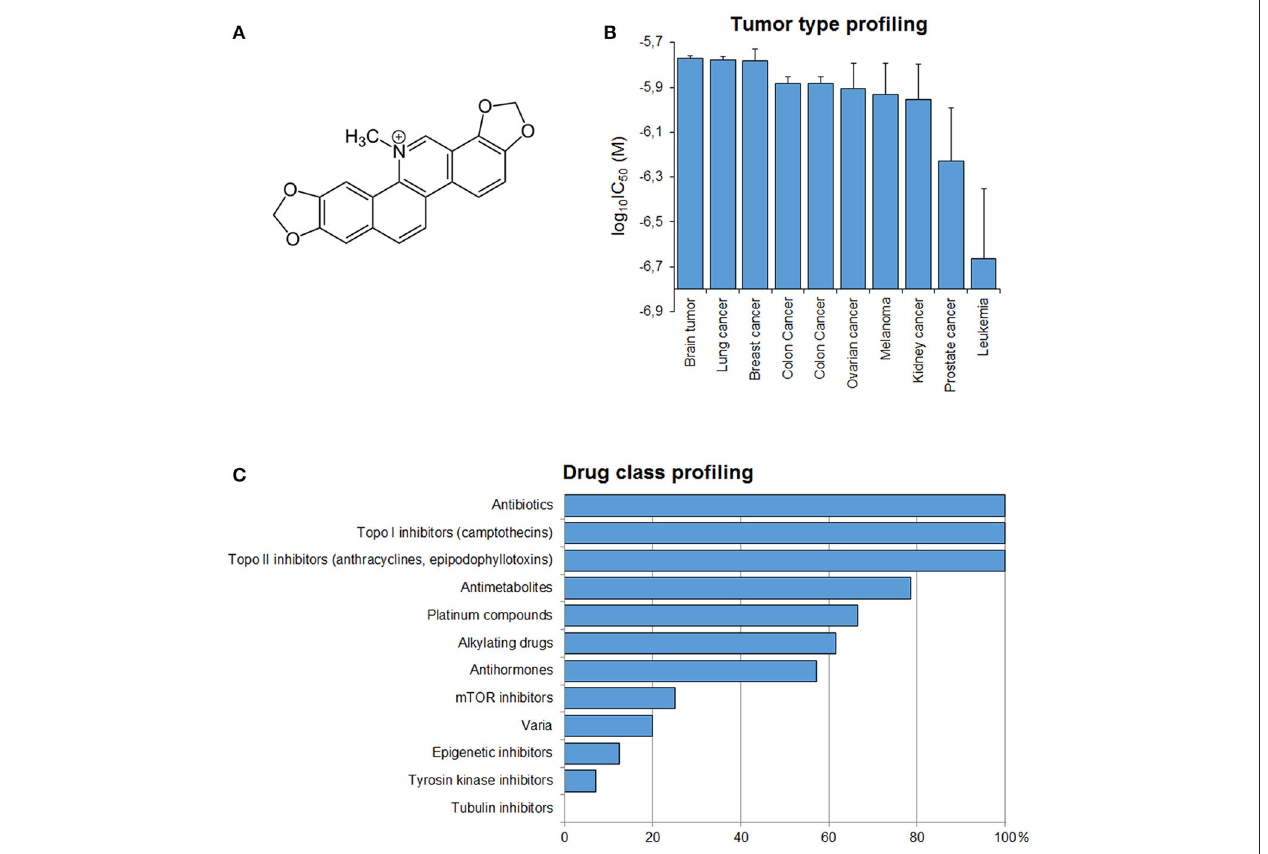
FIGURE 2 | (A) Chemical structure of sanguinarine. (B) Mean log 10 IC 50 values for sanguinarine of the NCI cell lines, mean values and S.E.M. of log10IC50 were grouped according to the tumor type of the cell lines. (C) Percentage of classes of established anticancer drugs, whose log 10 IC 50 values correlate with those for sanguinarine.